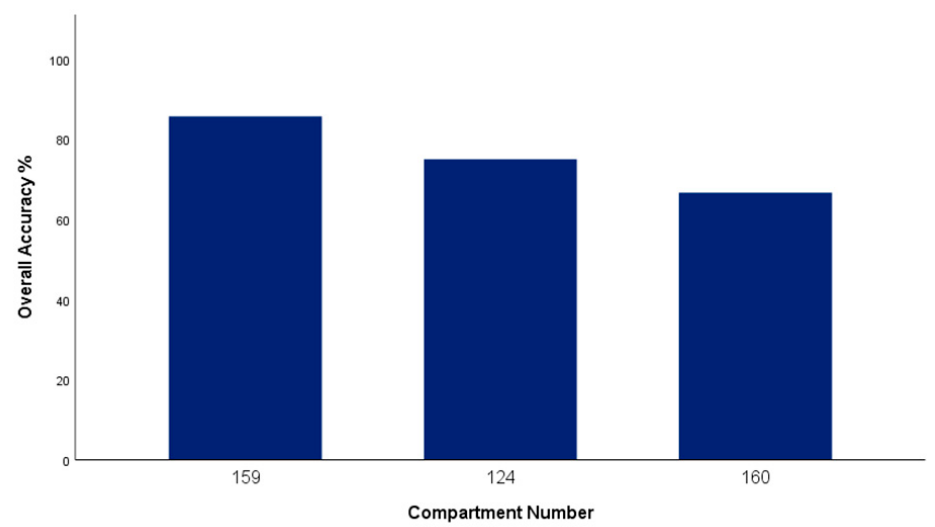
Figure 10. Overall accuracy of the stump detections by using integrated TM and OBIA method.